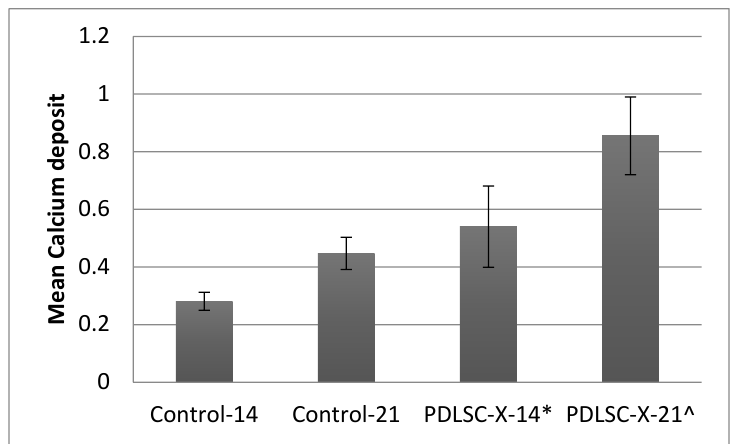
Figure 3. Mean calcium deposition among study groups ( μg) . * significant compared to Control-14, significant compared to Control-21.